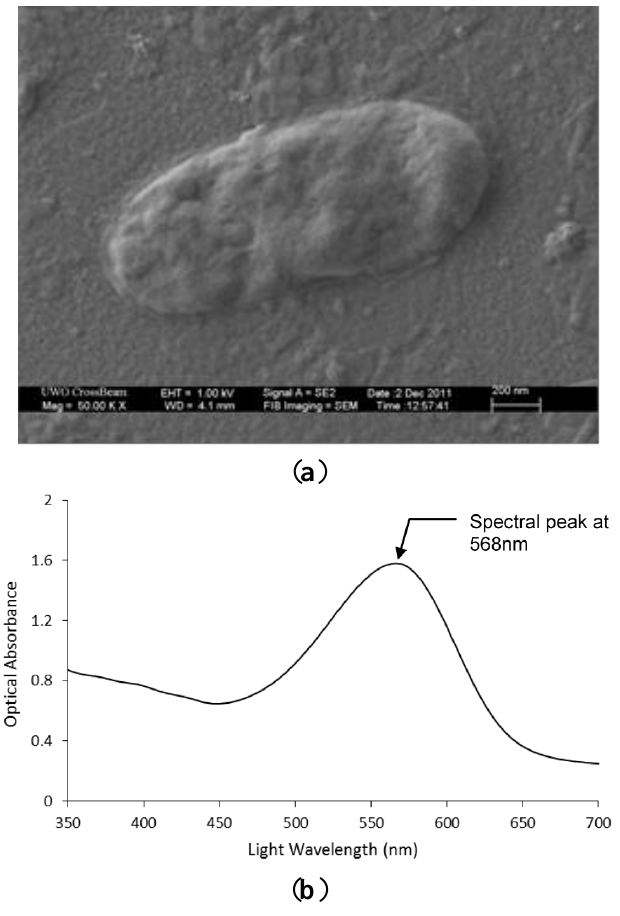
Figure 2. Bacteriorhodopsin (bR) membrane fragment and spectral absorbance in the visible light range. ( a ) SEM photograph of a bR purple membrane (PM) fragment ( b ) Measured optical absorbance of bR over the visible spectrum using a µQuant Microplate Spectrophotometer (from Bio-Tek